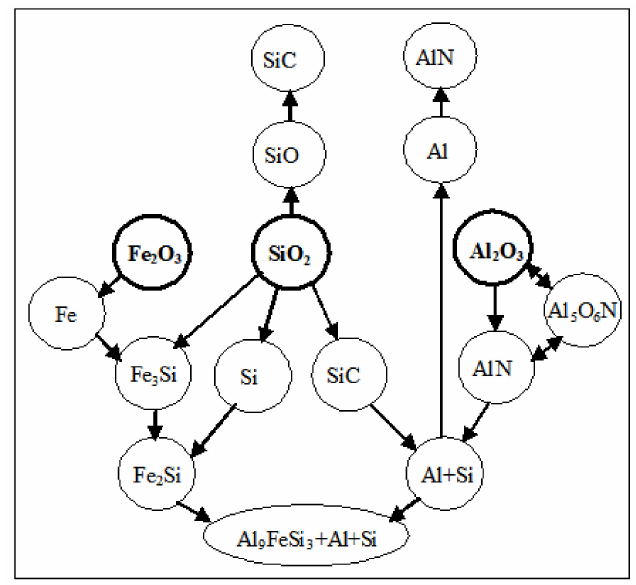
Figure 9. Schematic diagram of phase